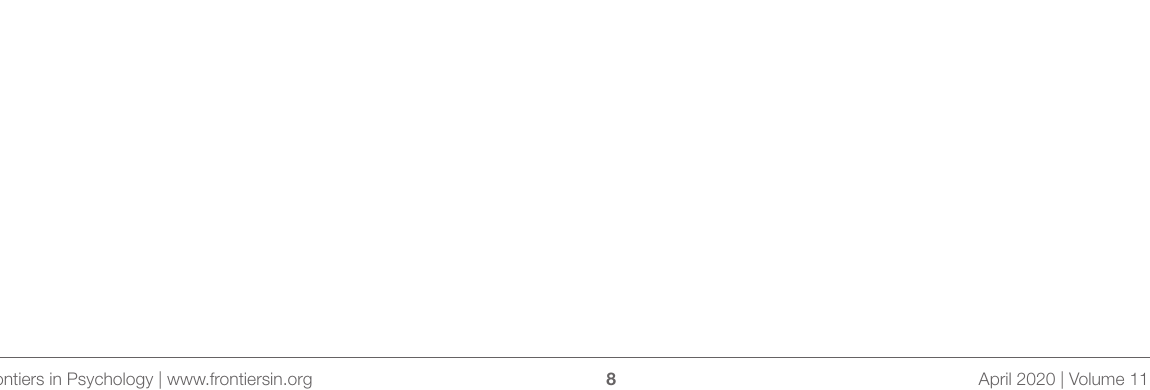
FIGURE A1 | Left panel: Means (and their 95% CIs) for the total rubric score in each group, separately for each problem. BS = “Black Site”, CA = “Cyber Attack”, KE = “Kernel Error”. Right panel: Means (and their 95% CIs) for the explicit problem questions in each group, separately for the same three